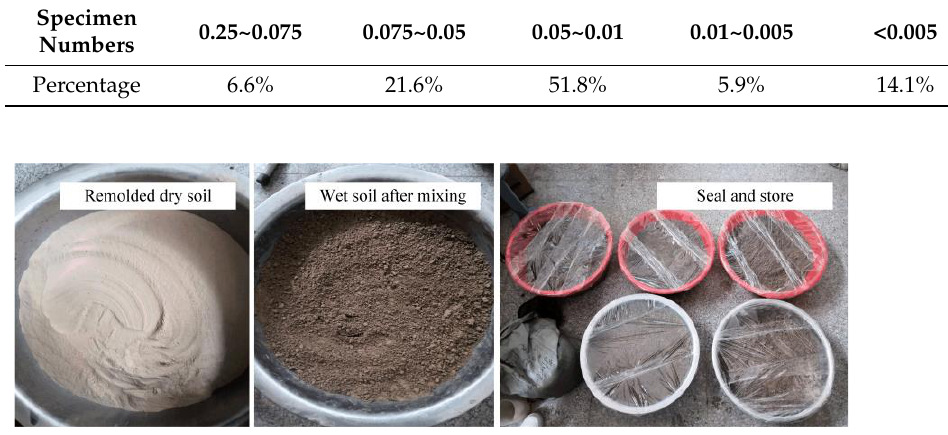
Figure 2. Preparation process for soil samples.